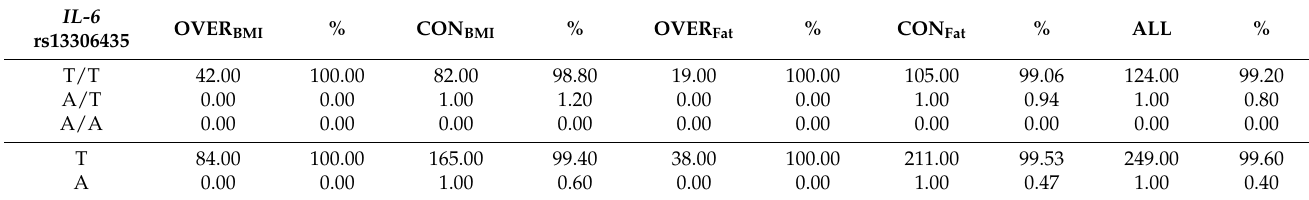
Table 6. Division of genotypes and alleles in the IL-6 gene